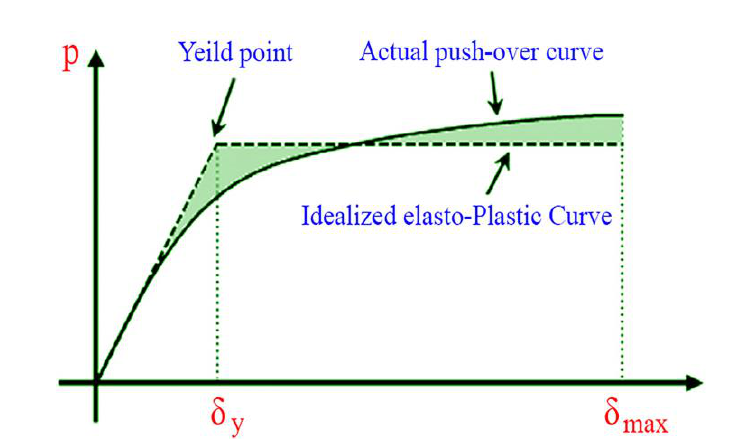
Fig. 12. The idealized diagram of the behavior of the steel shear wall.